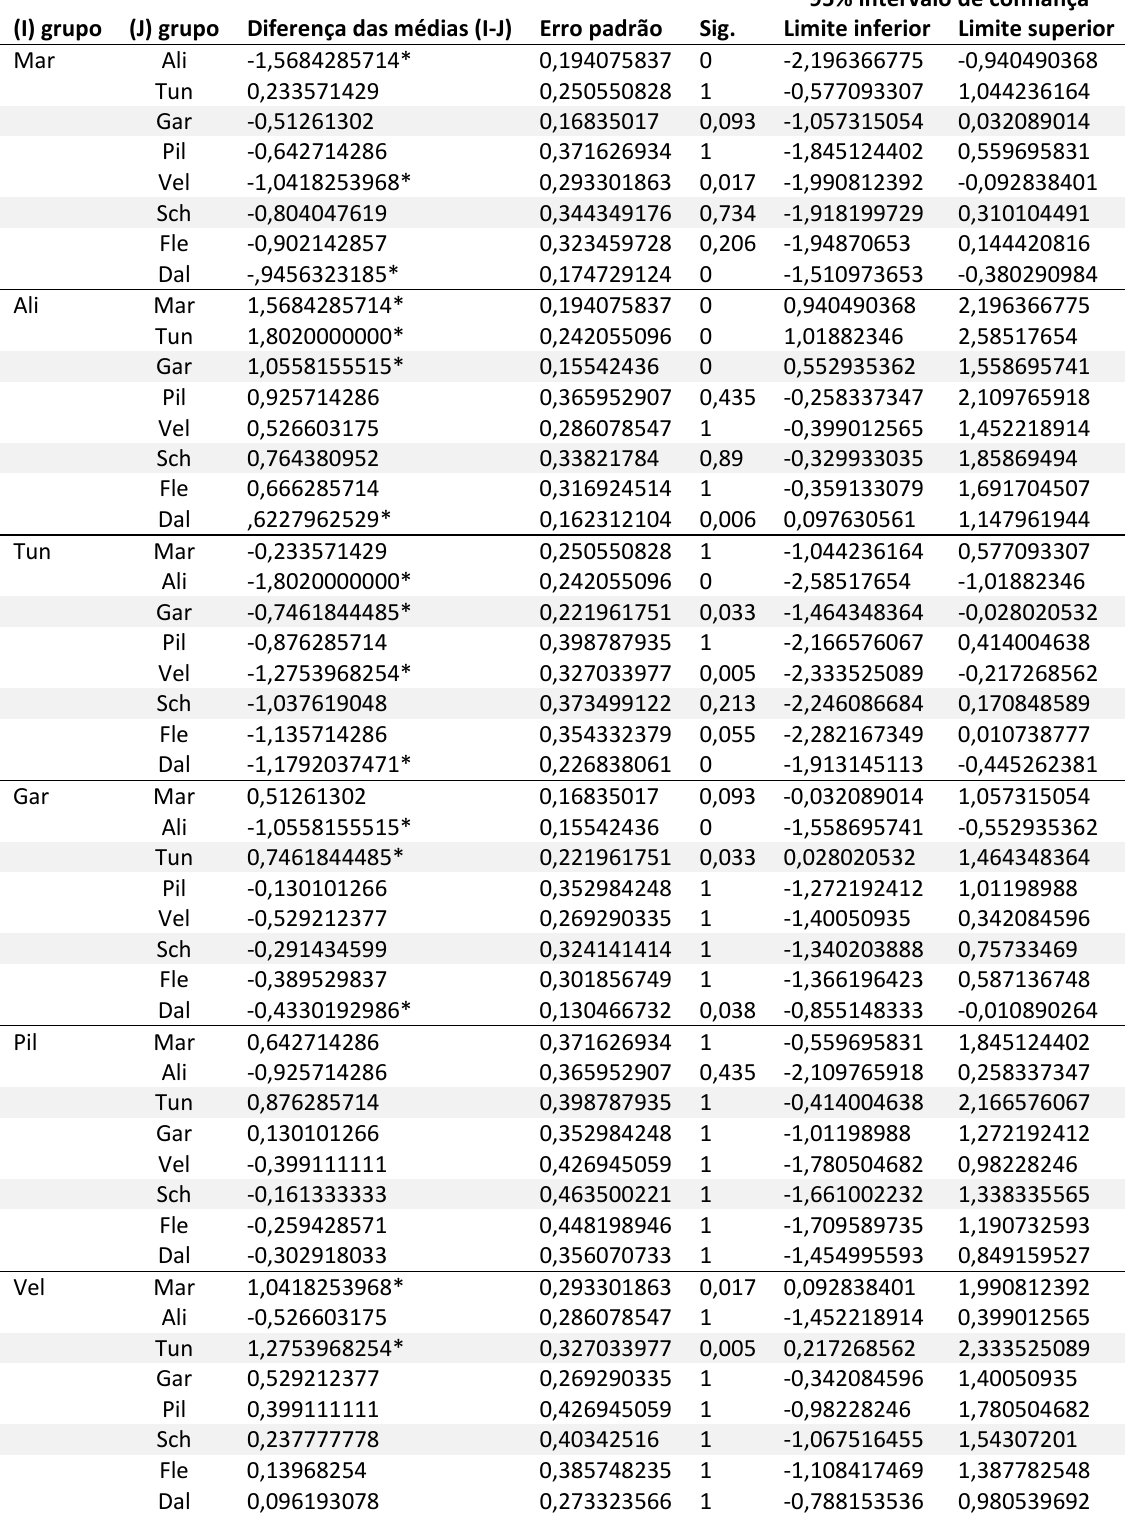
Tabela 6. Resultados da aplicação do método de Bonferroni. * pares de médias onde diferenças significativas ao nível de 0,05 foram identificadas. Table 6. Results of the application of the Bonferroni method. * pairs of means where significant differences at the level of 0.05 level were